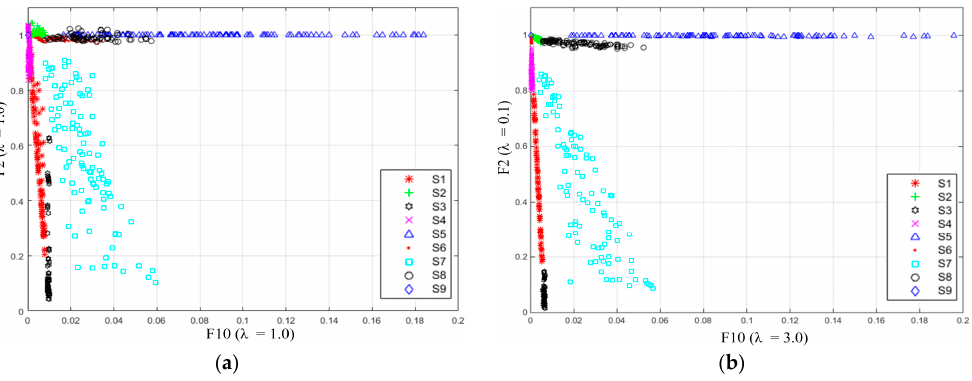
Figure 8. Comparison of F10 and F2 distribution behavior: ( a ) λ F10 = 1.0, λ F2 = 1.0; and ( b ) λ F10 = 3.0, λ F2 = 0.1.